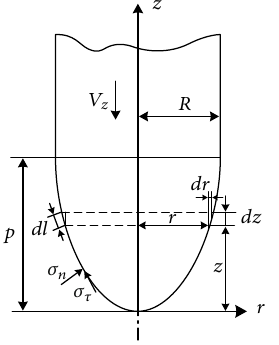
Figure 3: Force on arbitrary anchor